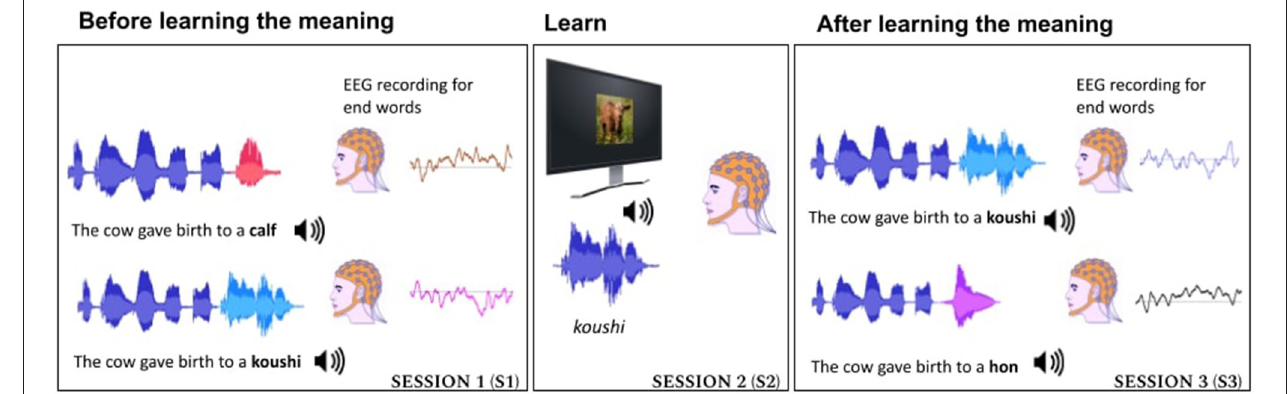
FIGURE 1 | Experiment pipeline consisted of three sessions. S1—where the subject listened to acoustics of Japanese words used in English context and English end-words in congruent and incongruent context. S2—where the semantics of Japanese words were introduced using images. S3—where the subject listened to Japanese words in English context (both congruent sentences and incongruent